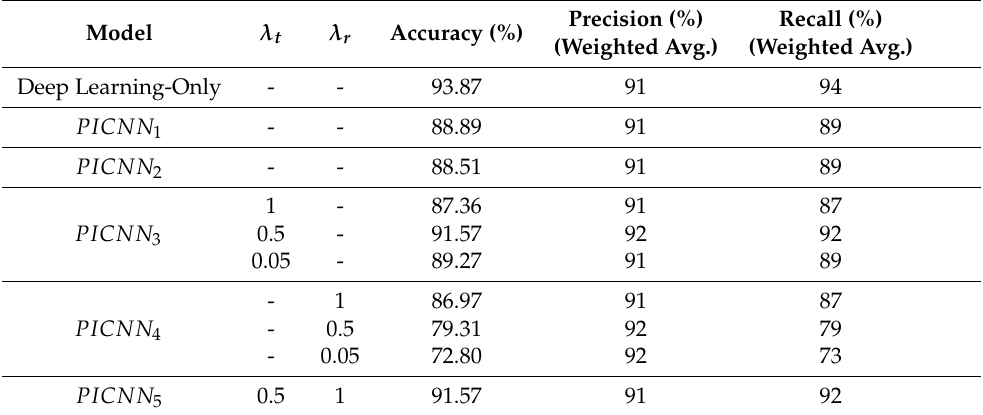
Table 4. Performance metrics for the baseline deep learning-only model and each version of the physics-informed model when tested on the test data set.